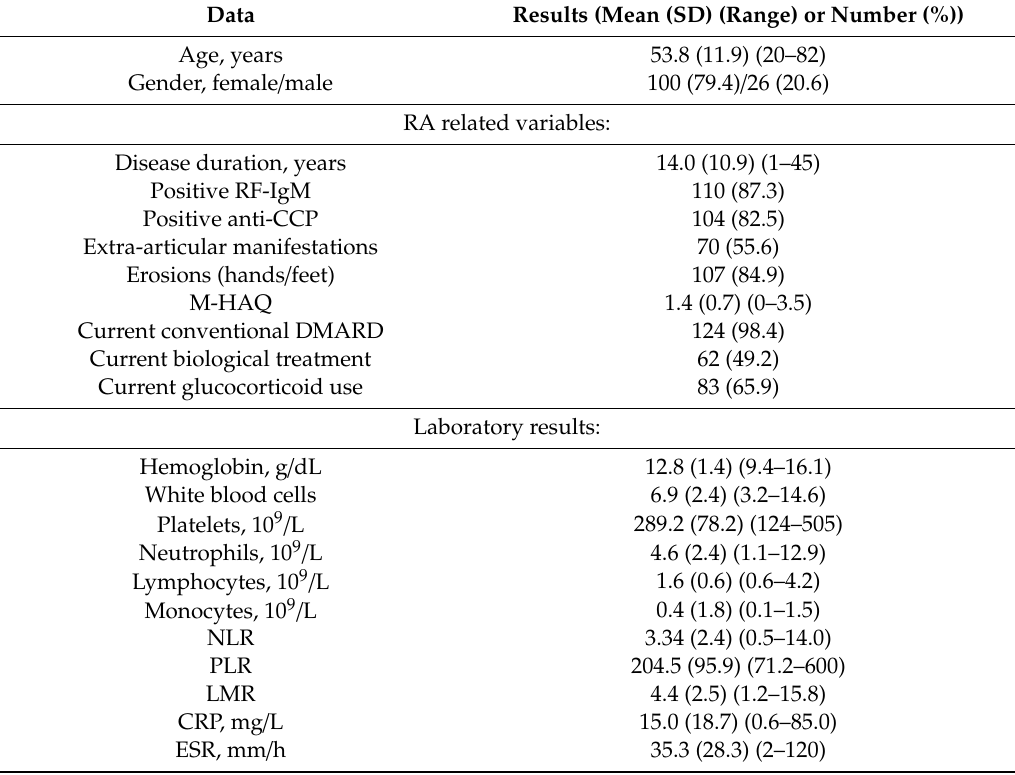
Table 1. Characteristics of 126 patients with